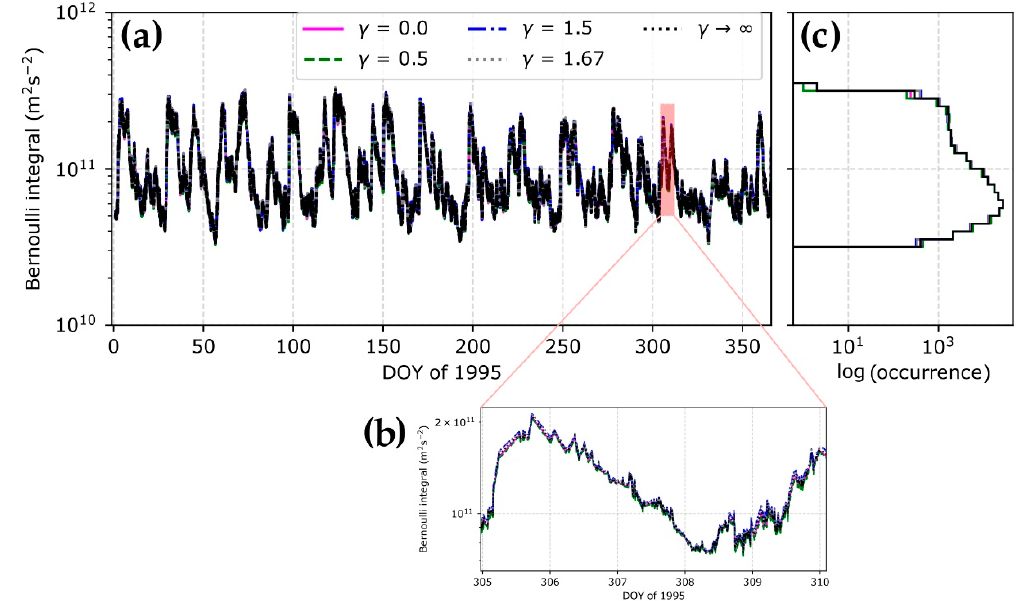
Figure 2. ( a ) Time series of the Bernoulli integral for different polytropic index values; (solid magenta) γ = 0, (dashed green) γ = 1/2, (dashed dotted blue) γ = 3/2, (dotted grey) γ = 5/3, and (dotted black) γ → ∞ . ( b ) The Bernoulli integral for the considered γ values in a short sub-interval from day 305 to day 310 of 1995. ( c ) Histograms of the Bernoulli integral in 1995 for the different polytropic indices we assume here.